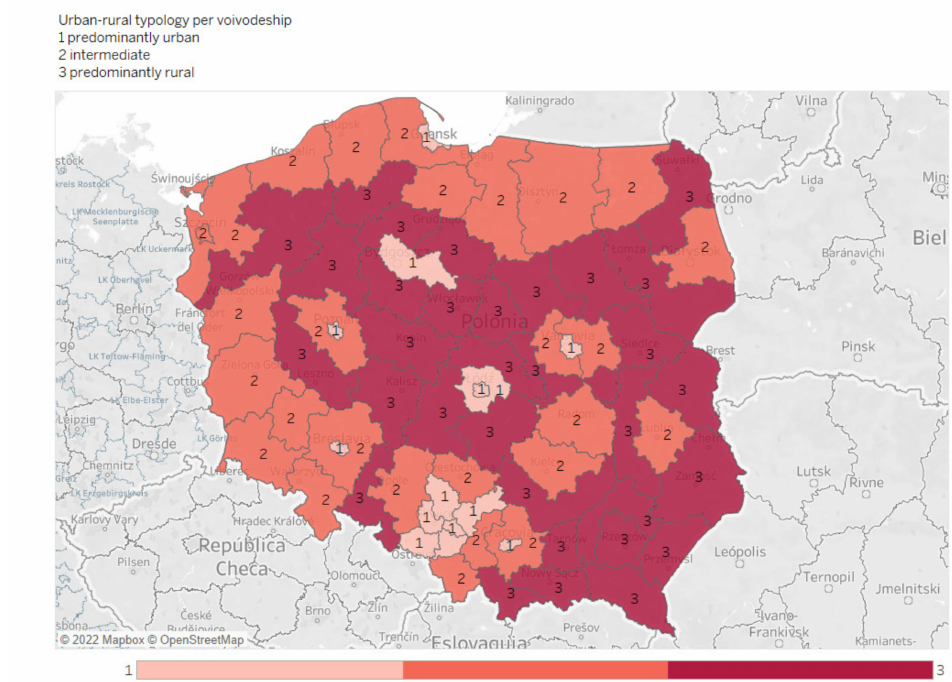
Figure 7. Urban–rural typology for each voivodeship using NUTS-3. Source: own elaboration using Tableau Desktop professional edition based on data extracted from